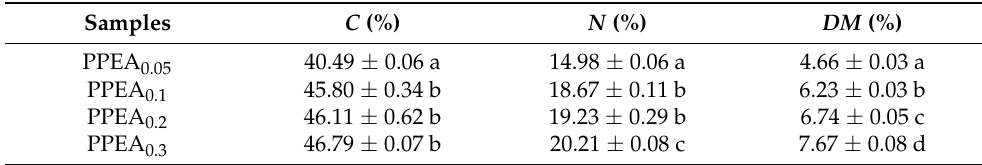
Table 1. The elemental compositions and degrees of modification ( DM s) of PPEAs. Samples C